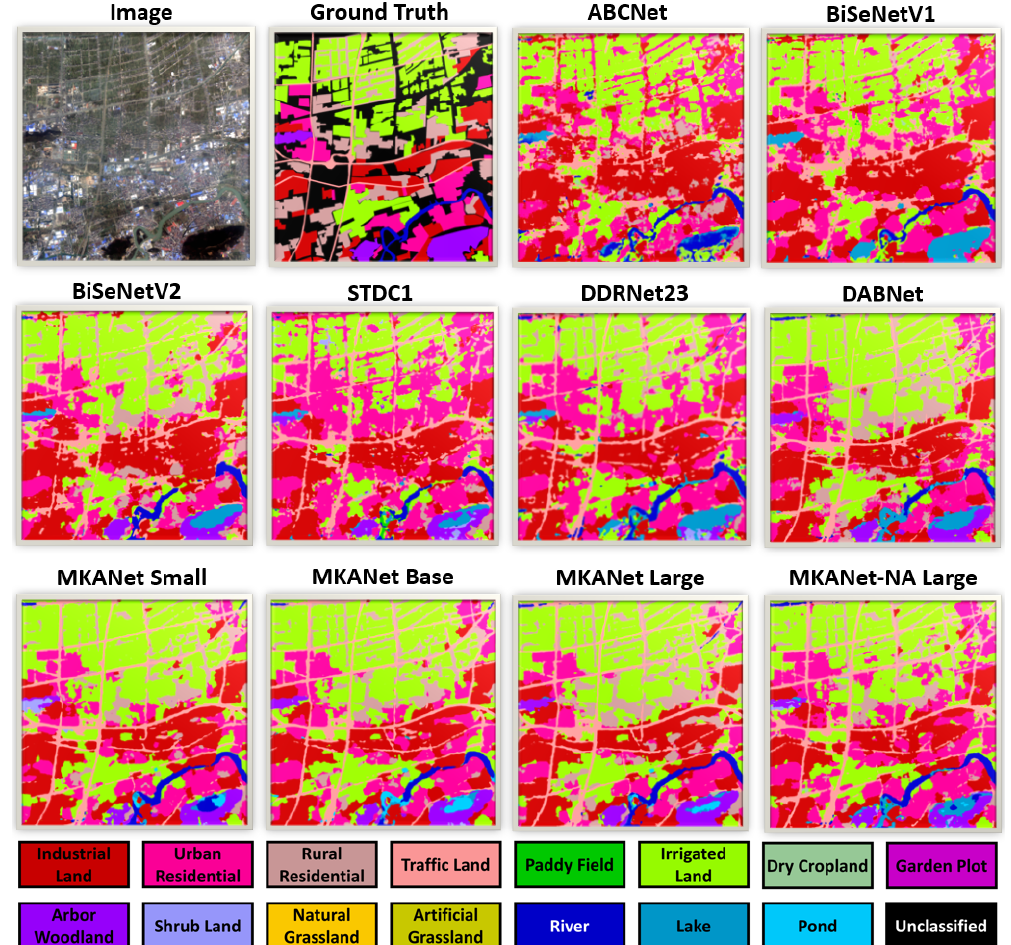
Figure 12. Comparison of the masks predicted by different methods on the GID Fine Land Cover Classification